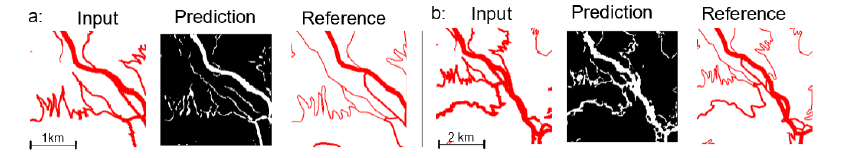
Figure 13. Effect of windows size on generalisation. ( a ) 2.5 × 2.5 km tile ( b ) 5 × 5 km